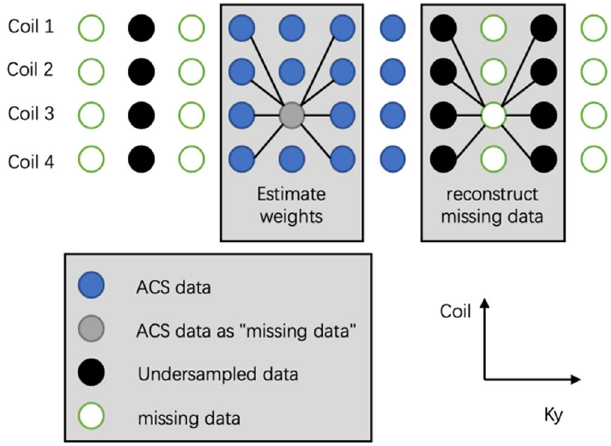
Figure 10. The basic principle of the GRAPPA algorithm is shown above. The sampled data around a sampled point in the ACS data is used to calculate the weight of these sampled points to the point. Then use the sampled data around the missing point to use the weight to calculate the value of the missing point. ORF = 2 in this